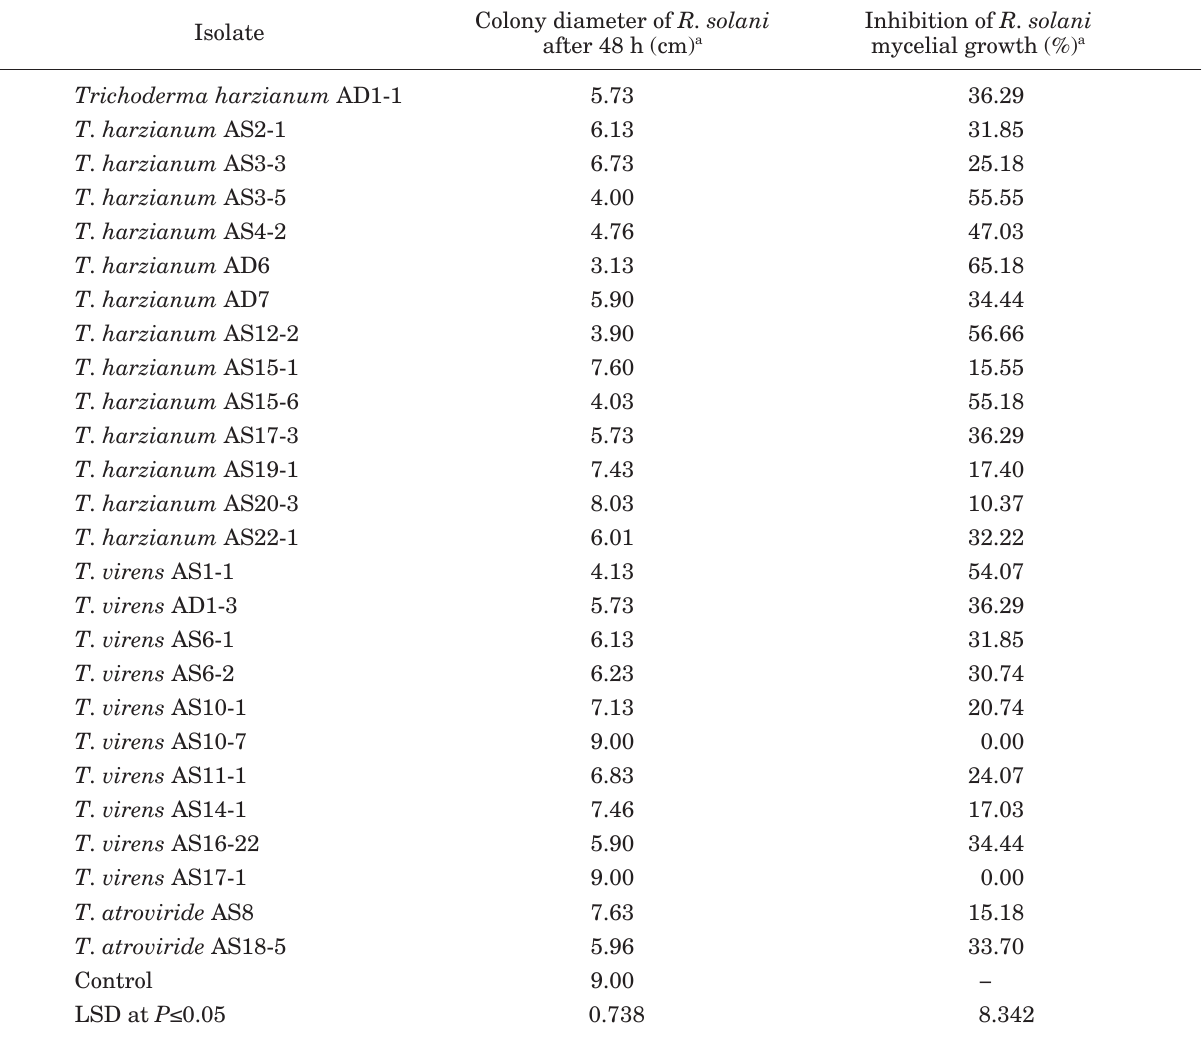
Table 3. Effect of volatile metabolites of Trichoderma isolates on the growth rate of Rhizoctonia solani . Colony diameter of R. solani Isolate after 48 h (cm)